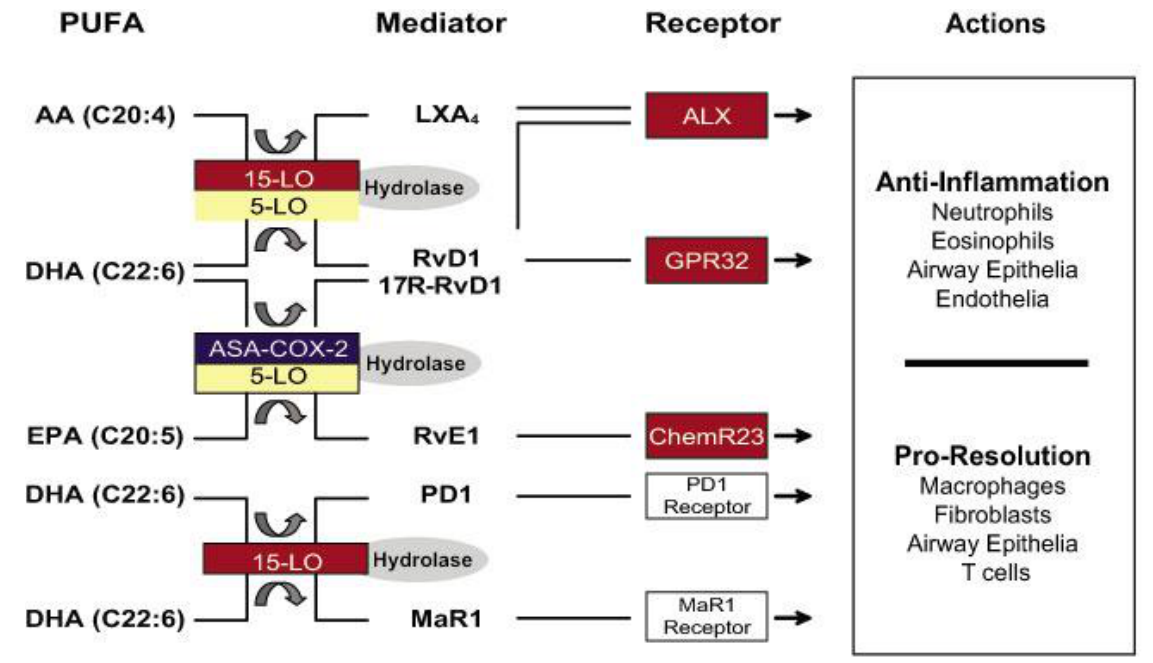
FIGURE 1. Molecular circuits of resolution for airway inflammation. During airway inflammation, select PUFAs are enzymatically transformed to bioactive mediators in complex biosynthetic circuits. These mediators elicit pathway- and cell type–specific responses that are both anti-inflammatory and